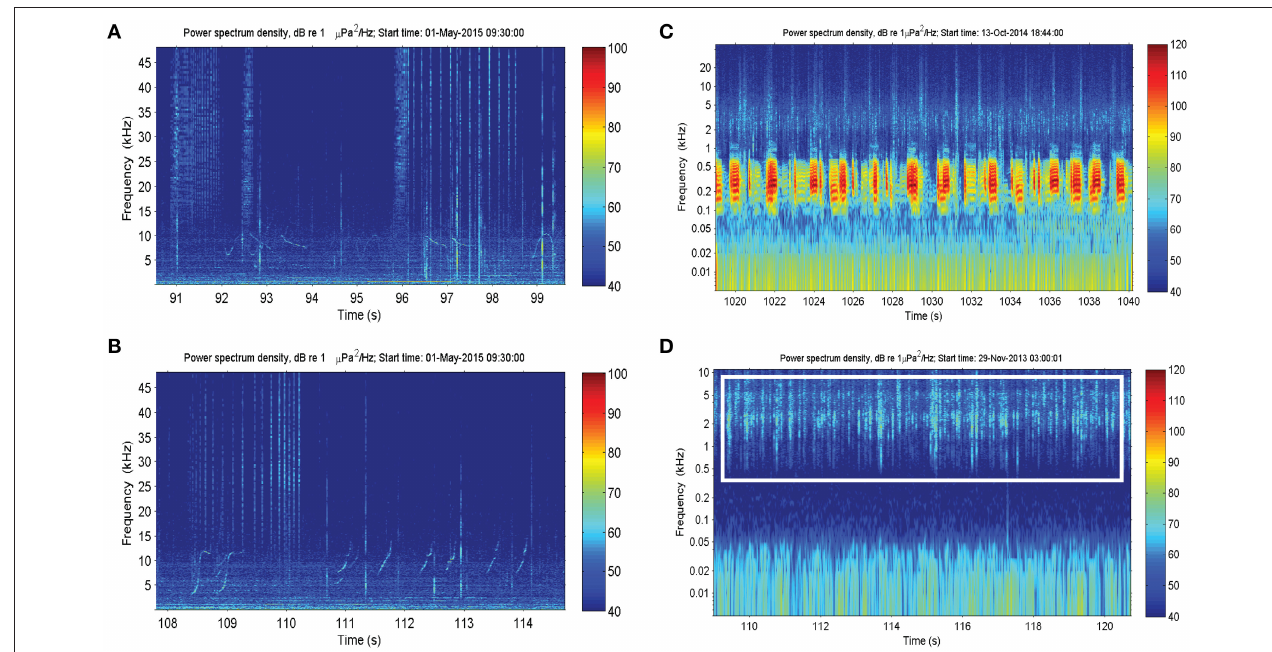
FIGURE 2 | Biotic sound sources recorded within the Swan River included: (A,B) the clicks and whistles of Indo-Pacific bottlenose dolphins; (C) mulloway fish choruses; and (D) snapping